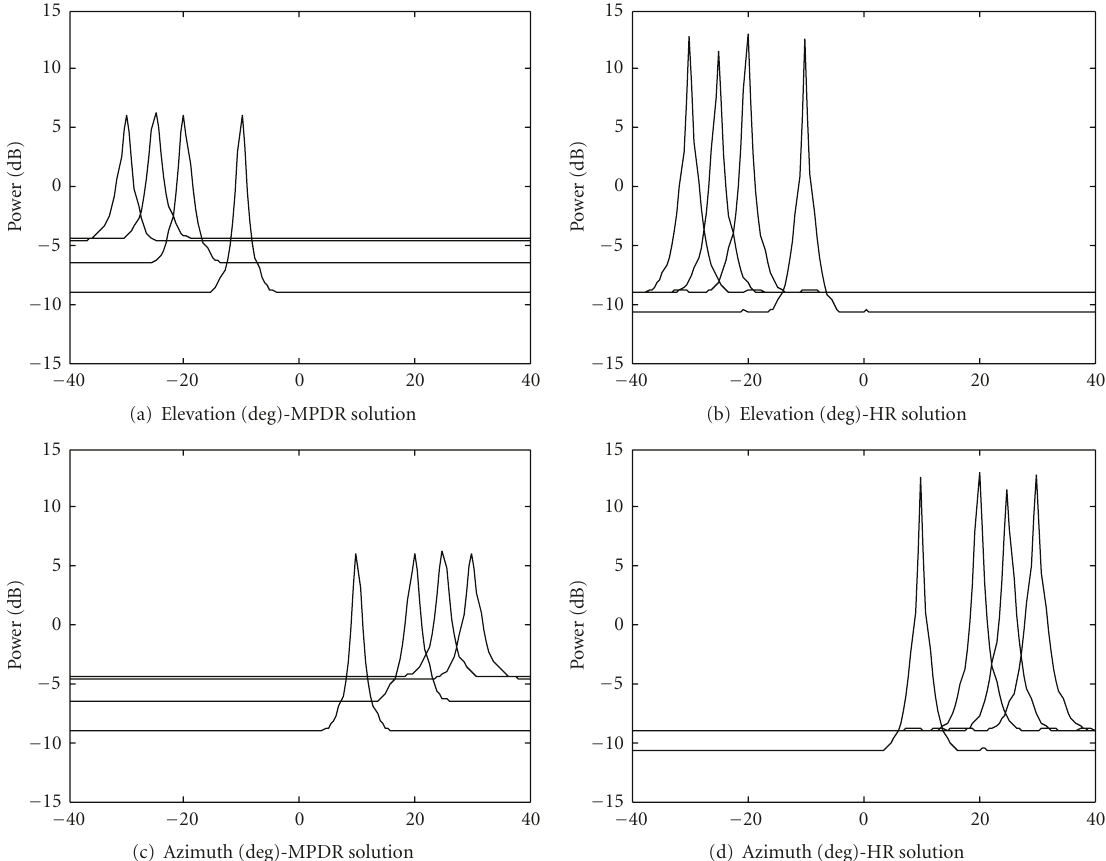
Figure 4: Bearing estimation for all four multipaths using all four lag estimates. These figures display the cuts across the peak values of the elevation/azimuth spectrum of the type displayed in Figure 3.